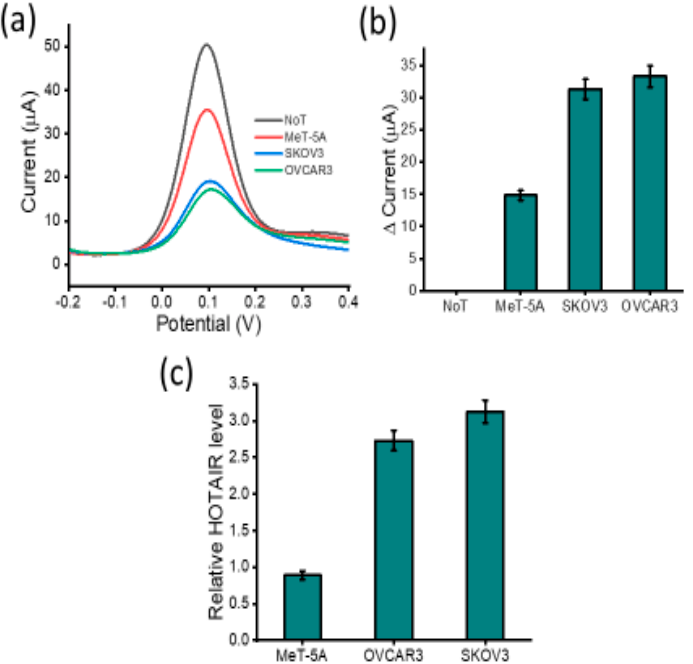
Figure 6. Assay cell line testing: ( a ) DPV readout displaying current output for benign (MeT-5A), carcinoma (OVCAR-3 and SKOV-3) in comparison to NoT and ( b ) change in DPV current response of the three cell lines in reference to the NoT. Error bars represent the standard deviation across three separate experiments. ( c ) RT-qPCR showing the relative HOTAIR expression levels in ovarian cancer cell line (SKOV3 and OVCAR3) and non-cancerous MeT-5A.